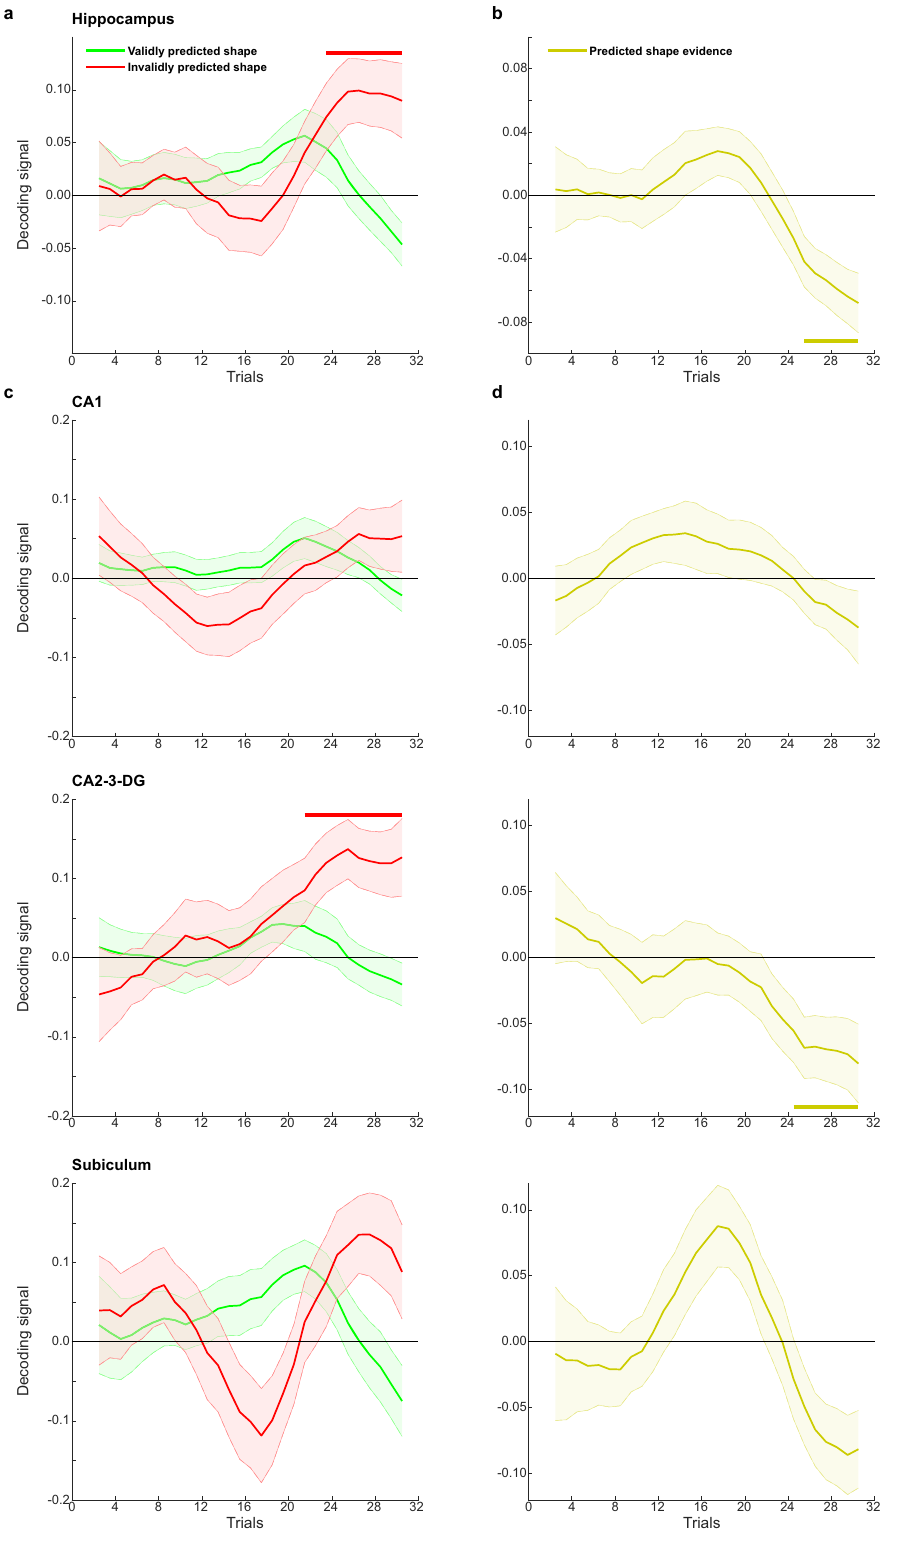
Fig. 2 Experiment 1 shape decoding over trials. a Decoding evidence for validly (green) and invalidly (red) predicted shapes in the hippocampus. b Decoding evidence for predicted (valid – invalid) shapes in the hippocampus. c Decoding evidence for validly (green) and invalidly (red) predicted shapes in hippocampal sub fi elds. d Decoding evidence for predicted (valid – invalid) shapes in hippocampal sub fi elds. Time courses were temporally smoothed using a sliding window approach (see “ Methods ” for details). Horizontal lines indicate signi fi cant clusters. N = 24 participants, shaded regions indicate